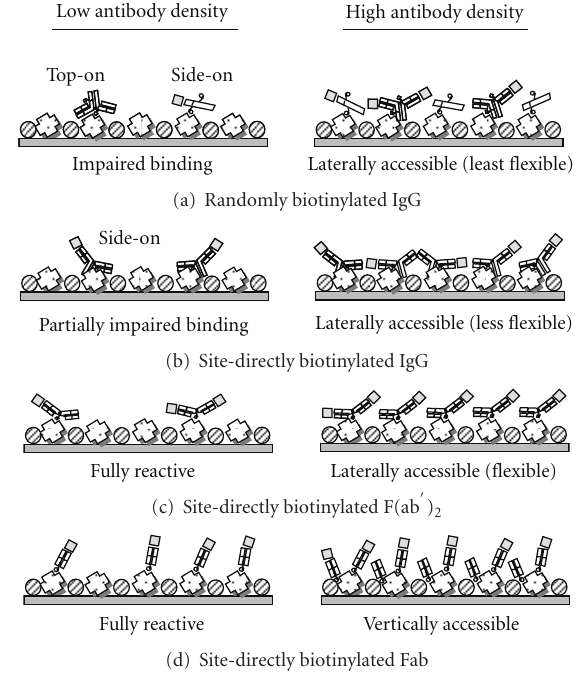
Figure 6: Equilibrium binding models of immobilized antibodies at solid surfaces. The models were devised on the basis of the variation patterns of the reactive antibody density (refer to Figure 4) and binding a ffi nity (refer to Figure 5) against the antibody concentration for four di ff erent biotinylated preparations (see text for details). The major factor controlling the antigen-antibody complex formation seemed to be molecular orientation at a low antibody density (left) and accessibility at a high density